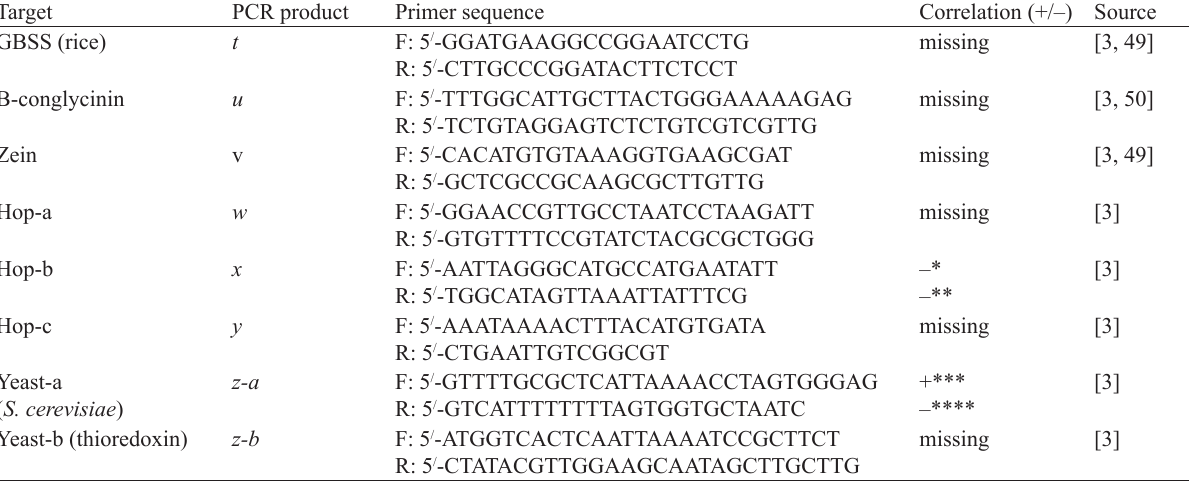
Table 5 Genetic targets used in detecting brewing barley substitutes and identifying hops and yeast in beer Target